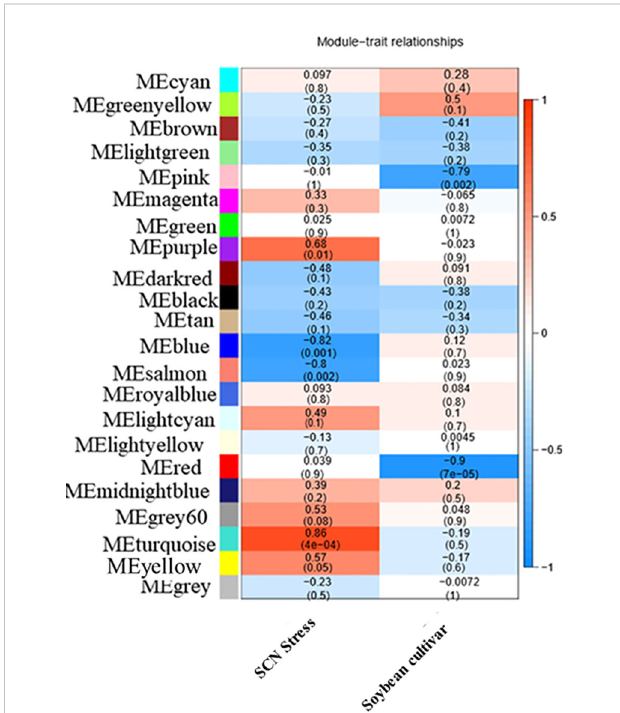
FIGURE 4 Heat map of the correlation between templates and traits. Each row represents a module eigengene, and each column represents a different characteristic. Each cell contained the corresponding correlation and p-value. The table is color-coded by correlation according to the color